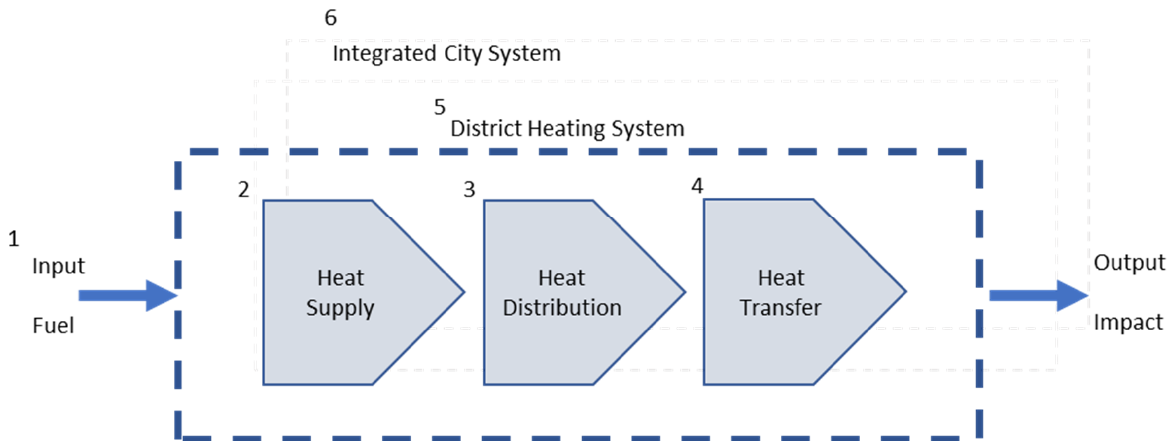
Figure 2. The value chain of DH adapted and interpreted from [4]: ( 1 ) fuel, ( 2 ) supply, ( 3 ) distribution and ( 4 ) transfer. All together, they make up the DH system ( 5 ), which is a part of integrated city systems ( 6 ). All relevant articles were coded to one group only, and all groups were made mutu- ally exclusive.